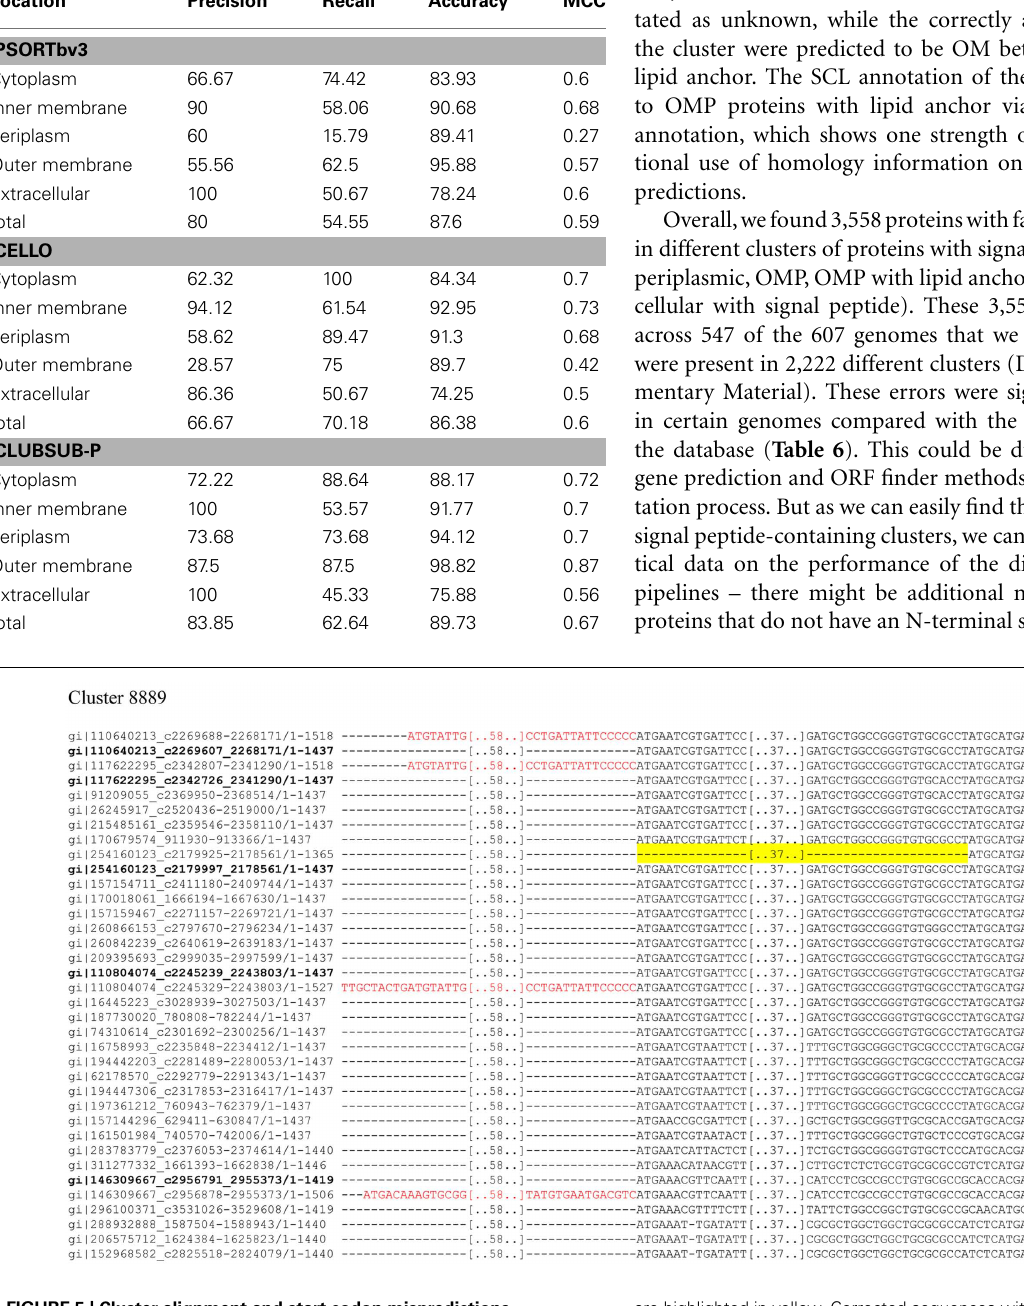
FIGURE 5 | Cluster alignment and start codon mispredictions (sequences are labeled with gene identifiers). The alignment shows extended and shortened ends of orthologous sequences at the DNA level.Wrong extensions are colored in red, and shortened sequences